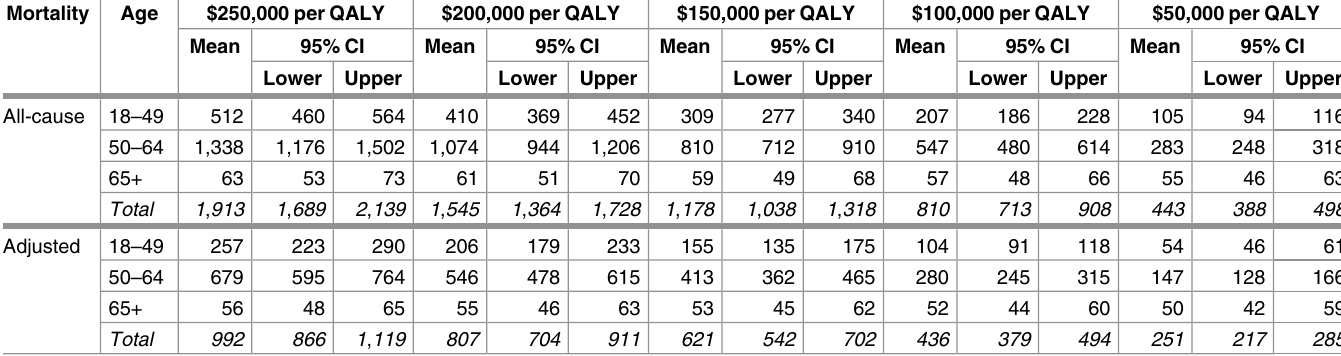
Table 12. Sensitivity analysis to estimatethe annual economic burden using direct medical costs, lost productivity and monetary value of quality adjusted life years(QALYs) lost for different monetary values per QALY by all-cause and respiratory or circulatory cause of death adjusted influ- enza-attributed mortality and age group in millions of US